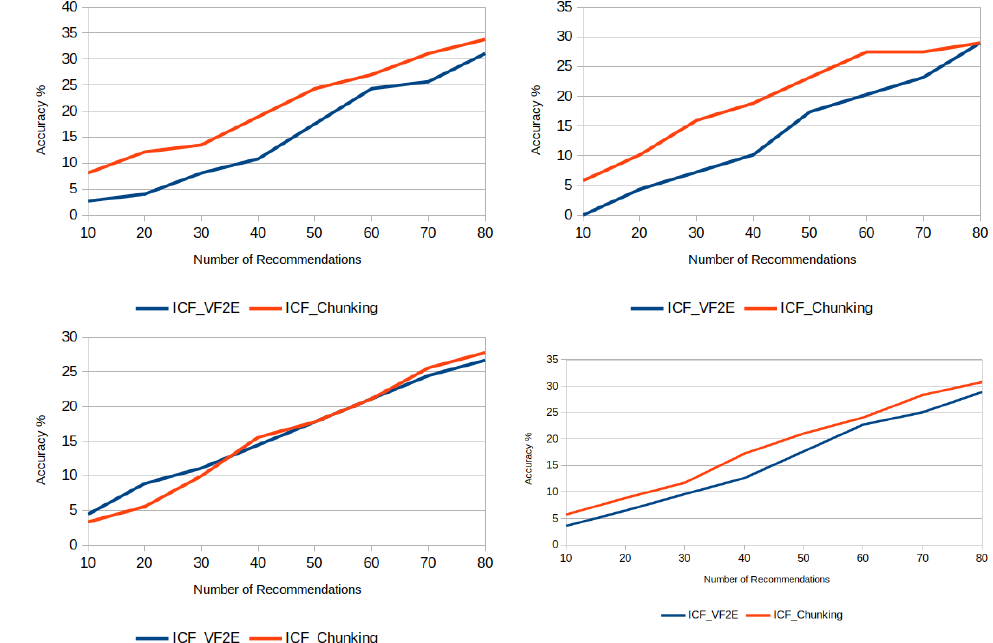
Figure 9. Performance comparison of proposed ICF_Chunking technique with baseline methods (VF2E) for a group of three users in each graph and the average results graph of these